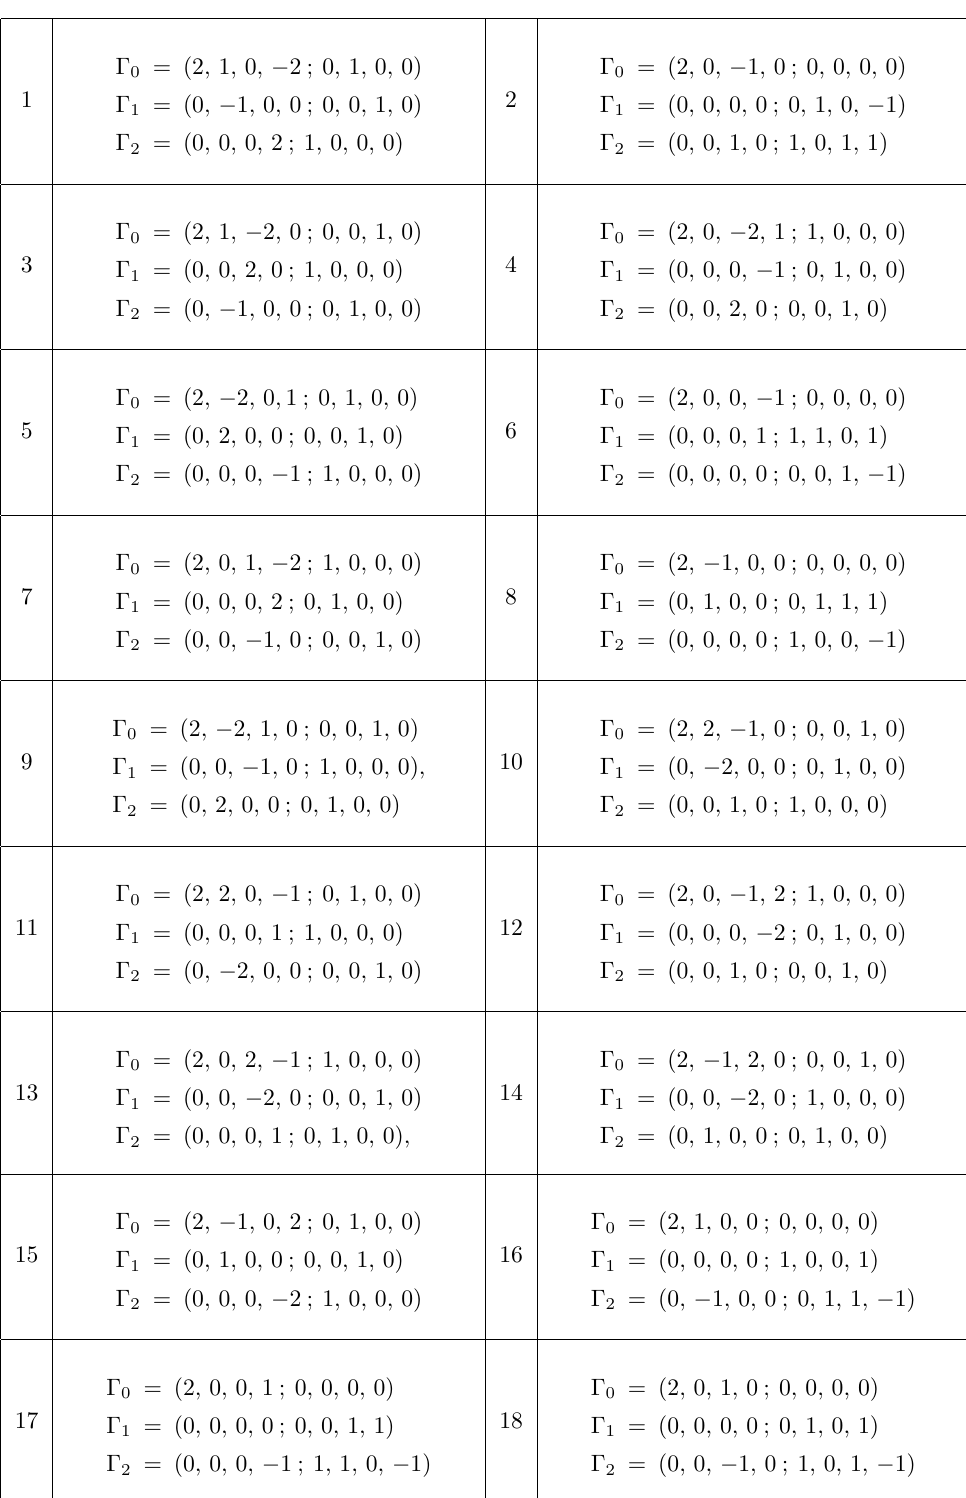
Table 2 . The 18 multicenter solutions with global D-brane charges ( Q D 6 ; Q 1